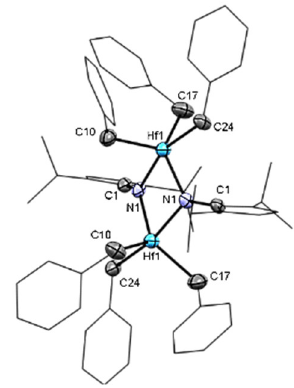
Figure 1. ORTEP drawing of complex 1 [(Im i Pr N) 2 Hf 2 (Bn) 6 ]. Hydrogen atoms are omitted for clarity.